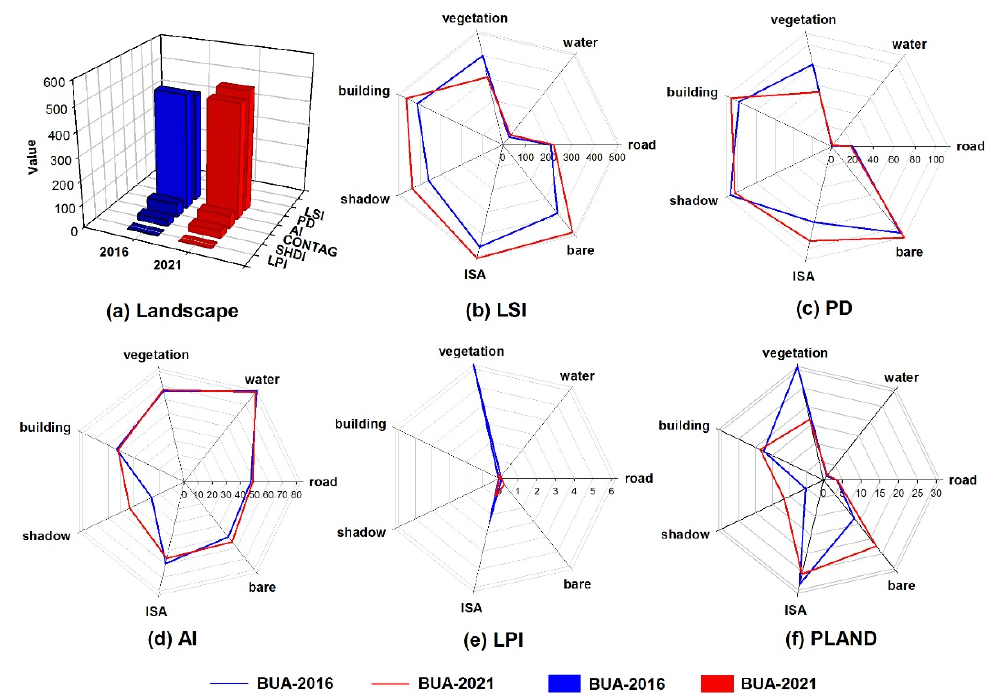
Figure 8. Landscape indices of the BUA in Beijing between 2016 and 2021. ( a ) Values of LPI, SHDI, CONTAG, AI, PD, and LSI for the landscape scale indicator; ( b – f ) represent the values of LSI, PD, AI, LPI, and PLAND, respectively, for the class scale